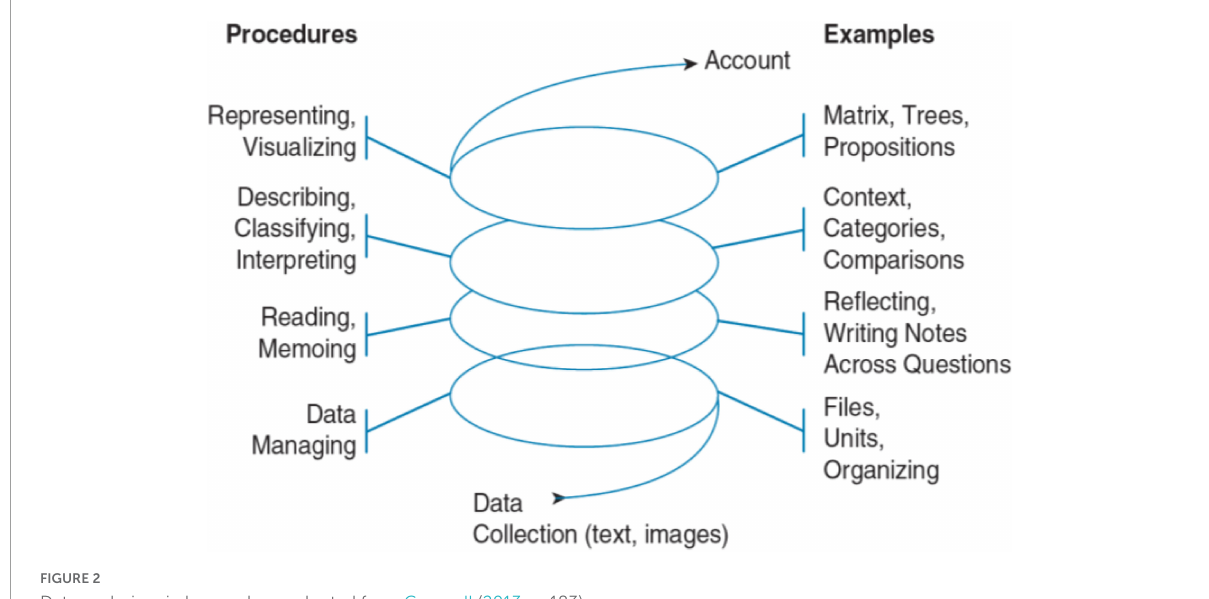
FIGURE2 Data analysis spiral procedures adopted from Creswell (2013, p. 183).